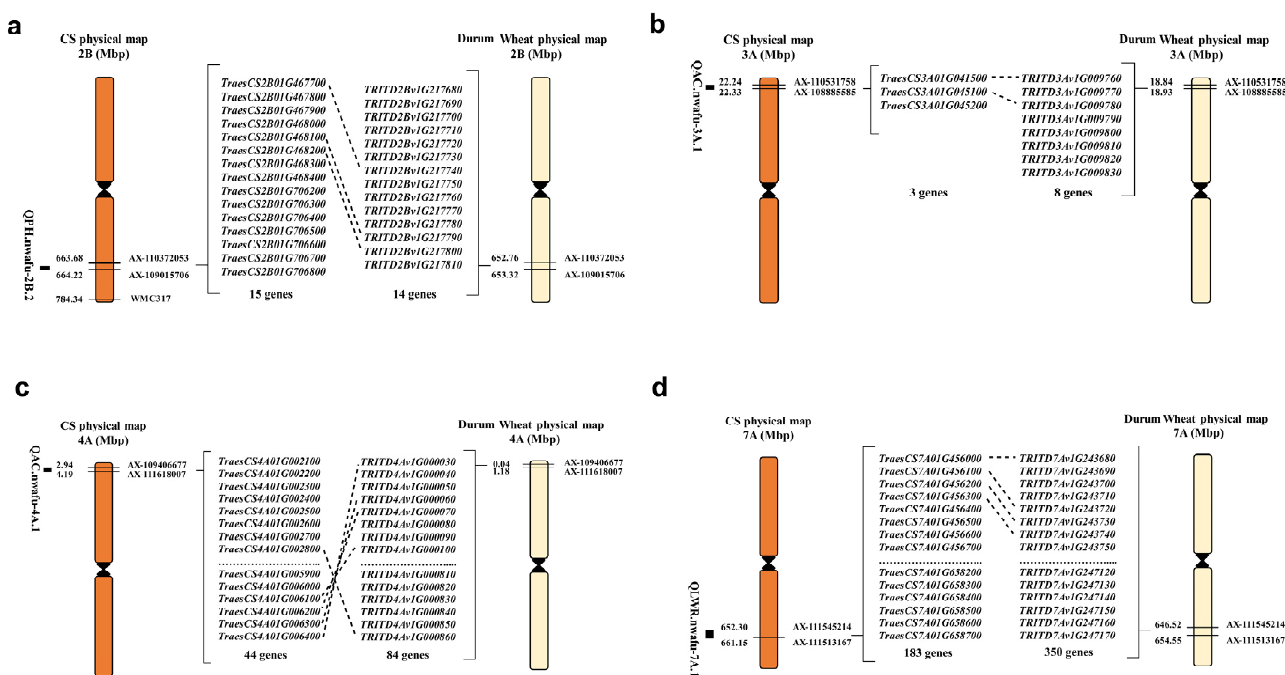
Figure 6. Physical maps of the QPH.nwafu-2B.2 ( a ), QAC.nwafu-3A.1 ( b ), QAC.nwafu-4A.1 ( c ), and QLWR.nwafu-7A.1 ( d ) on ‘CS’ and Durum Wheat; dotted lines indicate homologous genes.